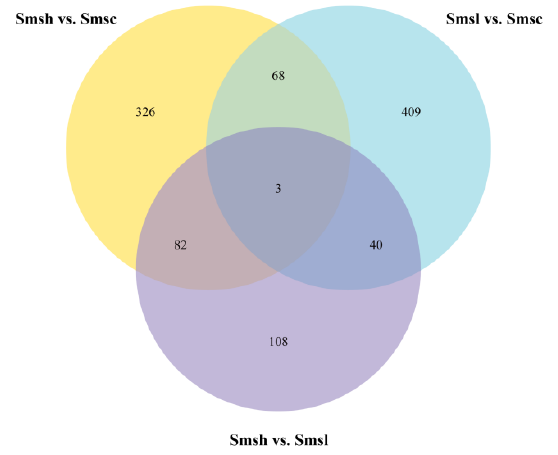
Figure 2. Volcano plot of DEGs in different salinity comparison groups. ( a ) Smsh vs. Smsc volcano plot; ( b ) Smsh vs. Smsl volcano plot; and ( c ) Smsl vs. Smsc volcano plot (Table S3: Diff_stat).